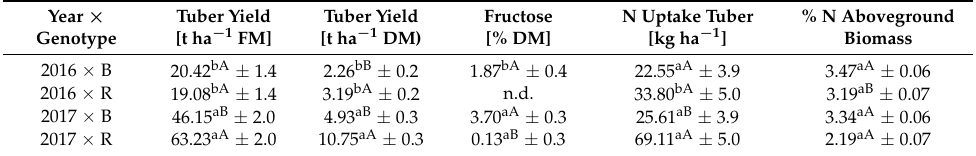
Table A2. Results of a multiple t-test at significance level of 5% after finding significant differences via global F-test for the factor year × genotype. Same lowercase letters indicate no significant differences between the years and same genotype. Same capital letters indicate no significant differences between genotypes within one year.